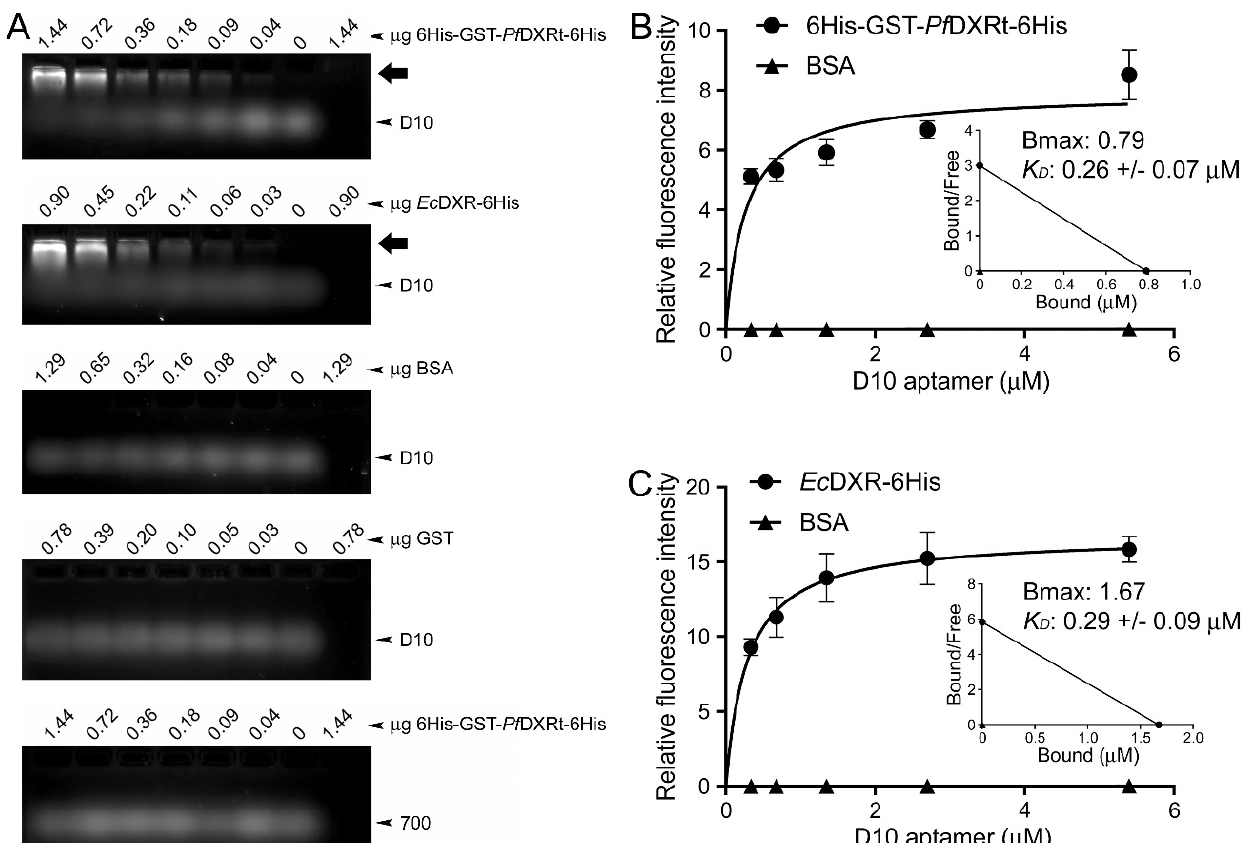
Figure 4. Characterization of the D10 aptamer evolved against Pf DXRt. ( A ) Electrophoretic mobility shift assay of the interaction of D10 with its target protein as part of the recombinant polypeptides 6His-GST- Pf DXRt-6His and Ec DXR-6His. The negative controls include analysis of D10 binding to BSA and GST and of aptamer 700 [34] to 6His-GST- Pf DXRt-6His. The arrows indicate the position of DXR-D10 complexes just entering the gel. The last lane on the right side of each gel contains no D10. ( B , C ) Determination of K D and Bmax for the binding of the 6FAM-labeled D10 aptamer to ( B ) 6His-GST- Pf DXRt-6His and ( C ) Ec DXR-6His. Insets: Scatchard plots. The negative control binding of D10 to free GST is presented in Figure S4.